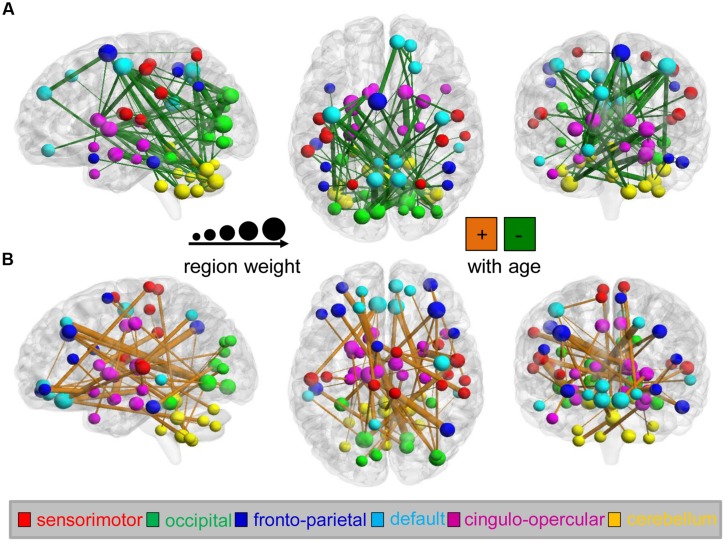
Maturation-dependent connections and regions in the dynamics of functional connectivity from the analysis on the total of subjects. Only connections with bootstrap ratios over 3.0 were selected and considered predictive connections. (A) Functional connections that decreased with maturation during the PLS analysis (shown in green) and maturation-dependent ROIs are displayed on the surface of the brain. Connection lines are scaled according to the bootstrap ratios. The color and scale of ROIs represent the functional networks and region weights (1/2 the sum of connection bootstrap ratios to and from that region). In contrast, (B) functional connections that increased with maturation are displayed in orange.